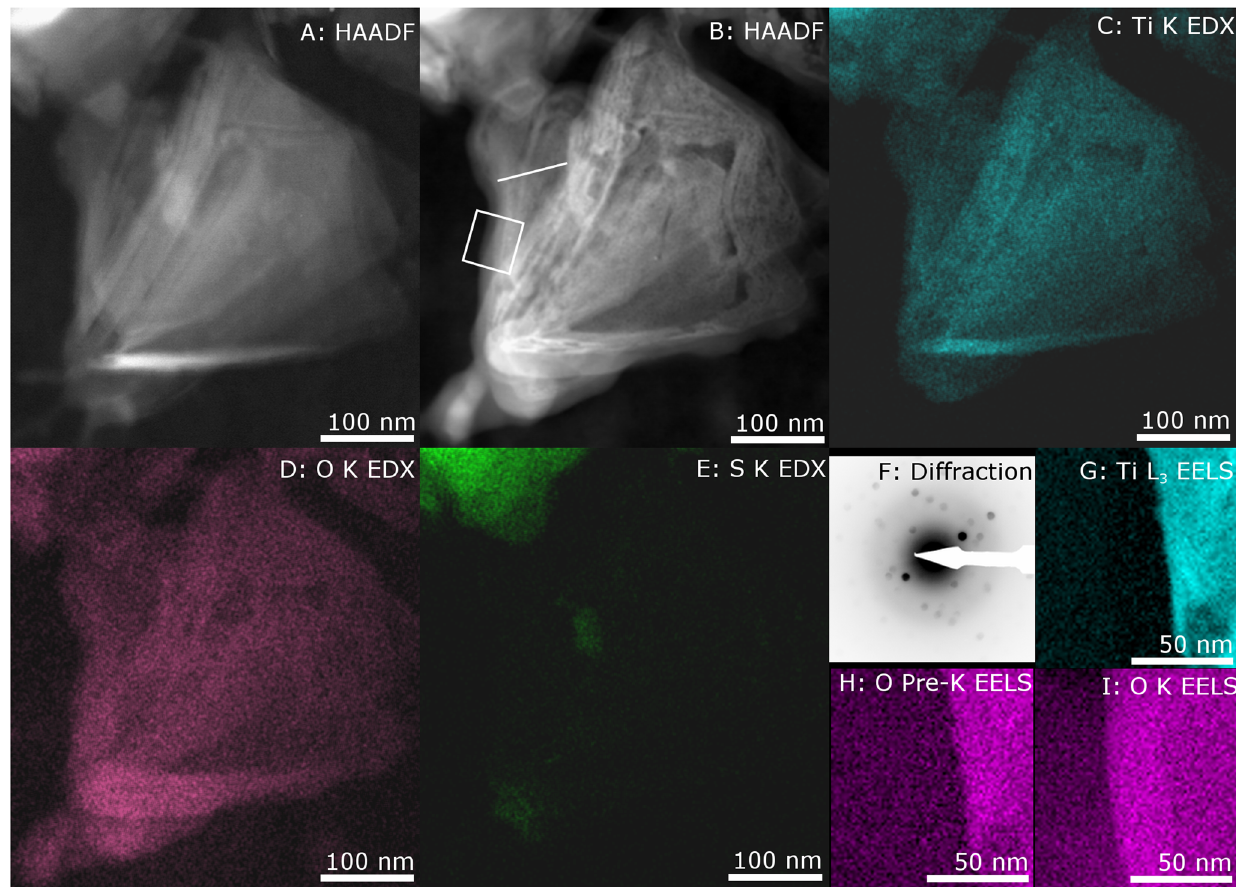
Fig. 4 Oxidation at 375 °C. a Initial HAADF of material at 150 °C in vacuum, b HAADF of region from which b – h were acquired after heating to 375 °C in 330 mbar gas, c Ti K EDX map, d O K EDX map, e S K EDX map, f Summation of nanoprobe diffraction patterns from line across edge of fl ake, contrast inverted for clarity, g Ti L 3 EELS map, h O pre-K EELS map, i O K EELS